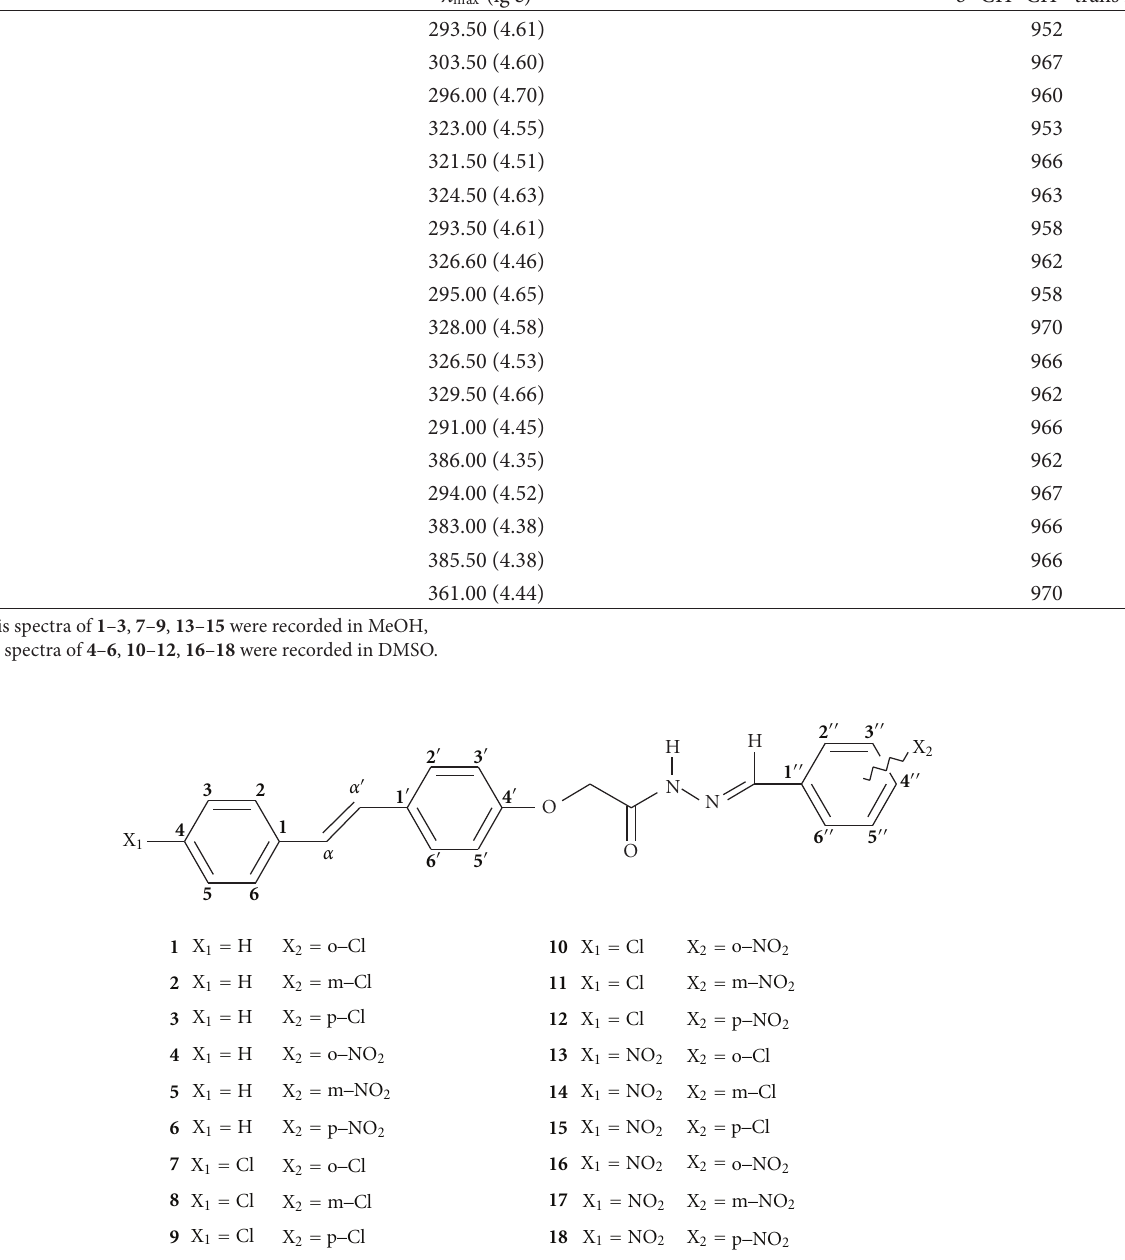
F 1: e structures of compounds 1–18